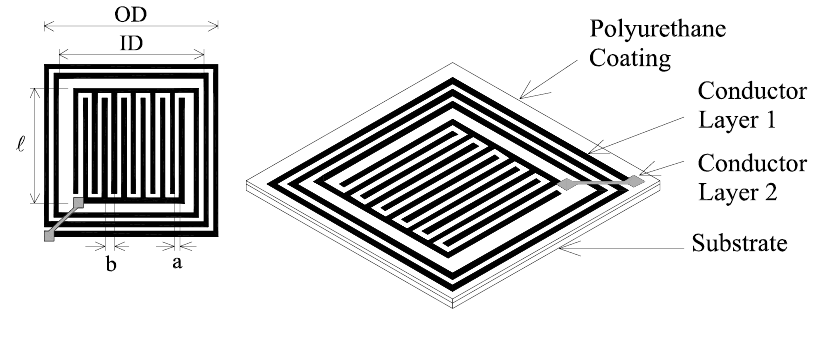
Figure 1. The LC sensor is comprised of a series-connected LC circuit printed on a plastic substrate. The sensor is covered with a layer of polyurethane to prevent the conductive biological medium from shorting the capacitor and damping the